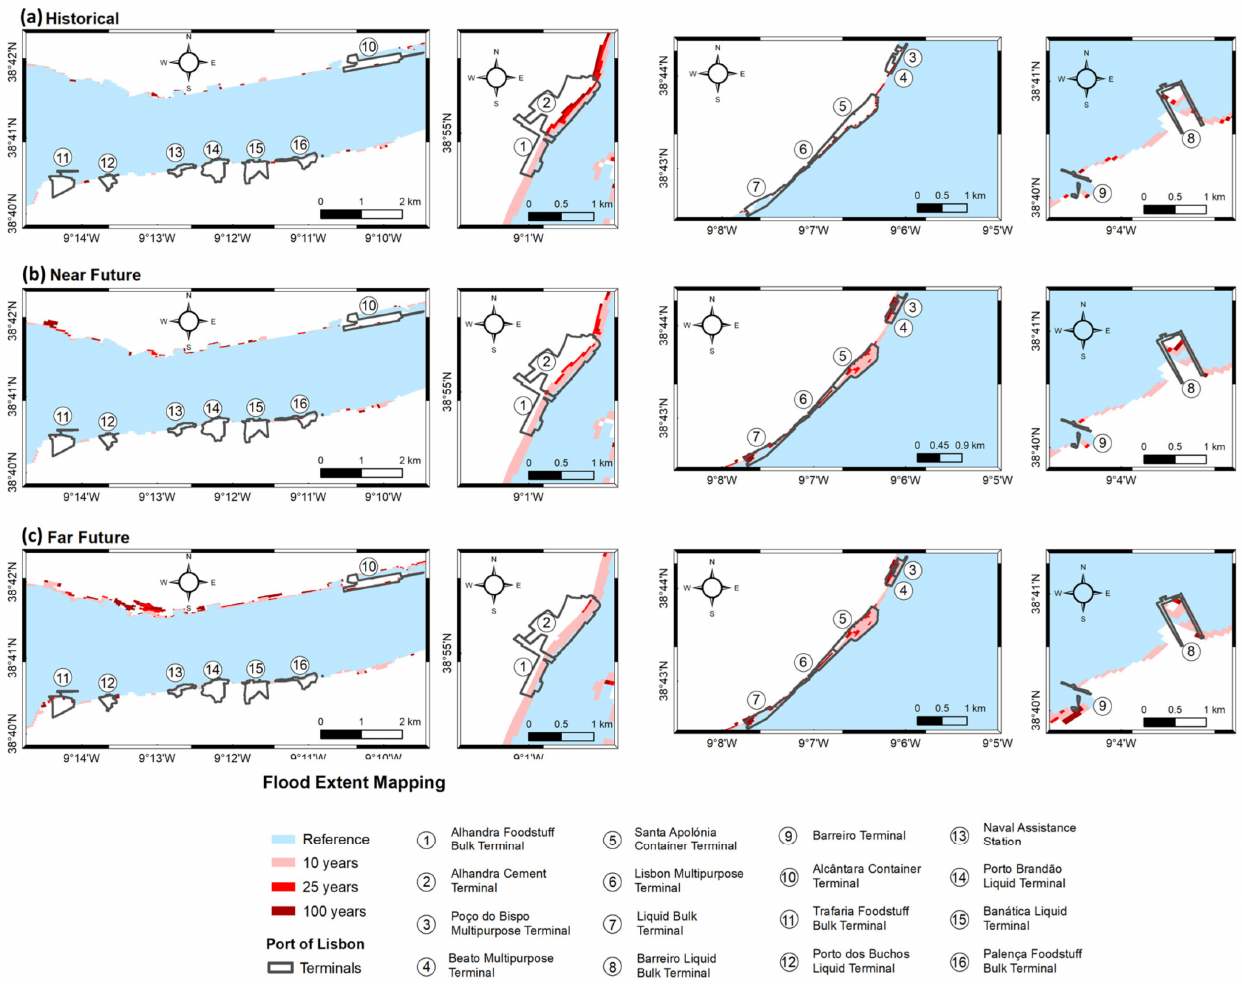
Figure 11. Flood extent mapping of Lisbon port’s terminals (numbers 1–16) located along the estuary margins. Reference scenario under the present climate and 10-, 25- and 100-year return periods are determined for the ( a ) historical (1979–2005), ( b ) near future (2026–2045) and ( c ) far future (2081–2100) climate periods.